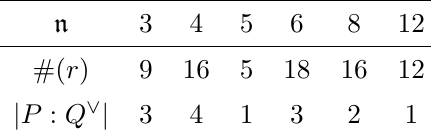
Table 3 . Numbers and sizes of groups of r -(cid:12)elds giving rise to the same embedding (cid:30) (cid:21) . dimension zero quotient lattice (cid:0) = Z rk+1 with (cid:0) = Z rk+2 j